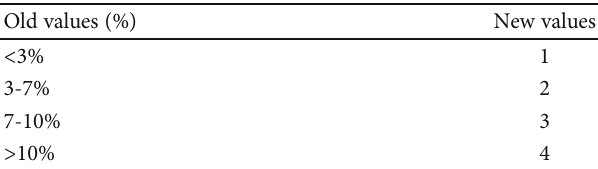
Table 9: Slope reclassi fi